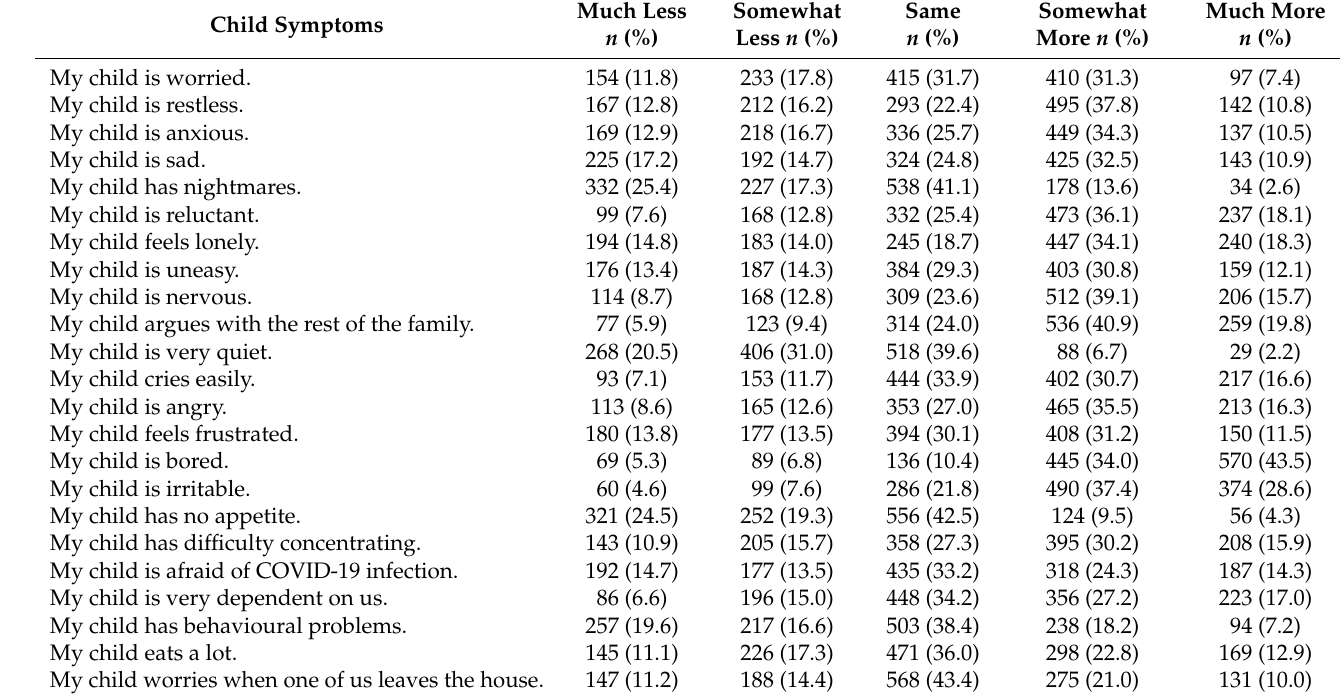
Table 2. Parents’ perceptions of the changes in child emotional and behavioural symptoms during COVID-19. Child Symptoms